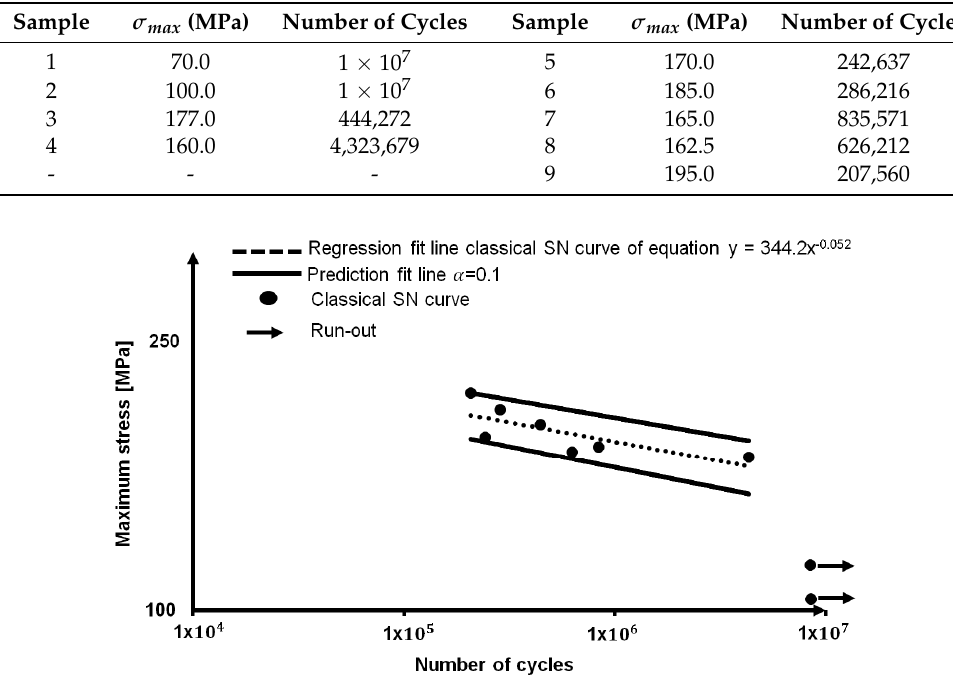
Figure 5. S-N curve and prediction interval for AA 5754-H111.